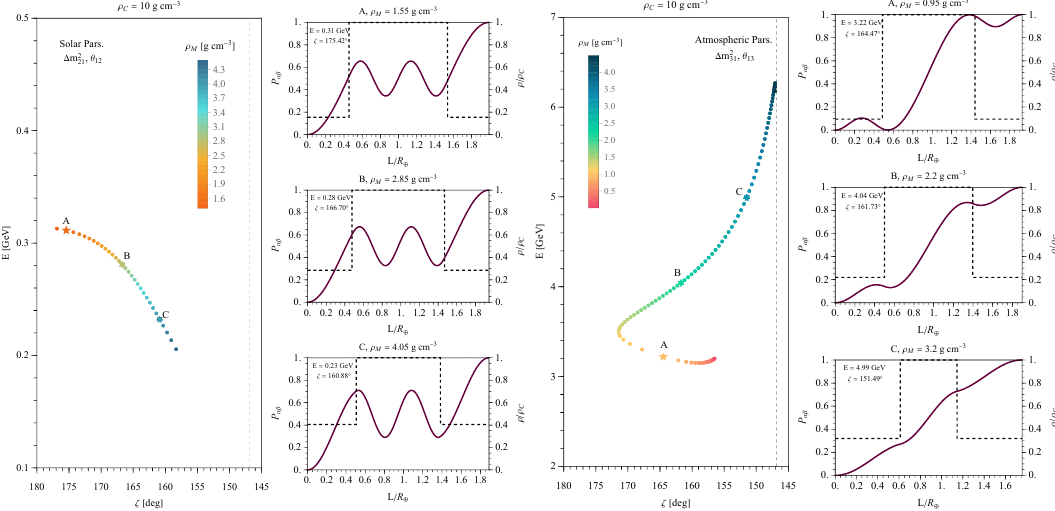
Figure 3 . Set of neutrino energies and zenith angles that produce a parametric resonance for several values of the mantle density for the solar (left) and atmospheric (right) driven oscillations. In both cases we fix the core density to be ρ = 10 g cm − 3 . We also present three specific cases C as “A” (five-pointed star), “B” (six-pointed star), and “C” (seven-pointed star), together with the probablity P as function of the travelled distance inside the Earth. The dashed lines indicate the αβ matter profile normalized w.r.t. the core